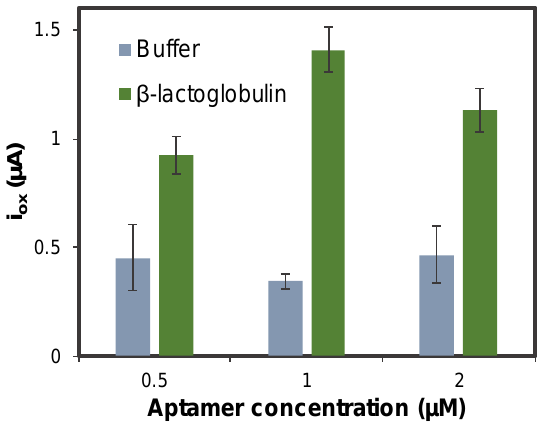
Figure 4. Optimization of the concentration of aptamer immobilized on the AuNPs@PLL/GSPE. Experimental conditions: [ β -LG] = 0 and 5.0 ng·mL − 1 , incubation time: 45 min, oxidation DPV recorded between – 0.60 V and +0.15 V, using the following conditions: modulation time: 0.02 s; interval time: 0.5 s; step potential 0.005 V; modulation amplitude 0.10 V. Solutions made in 0.1 M PBS, 150 mM NaCl pH = 7.4. Data are given as average ± SD (n = 3).